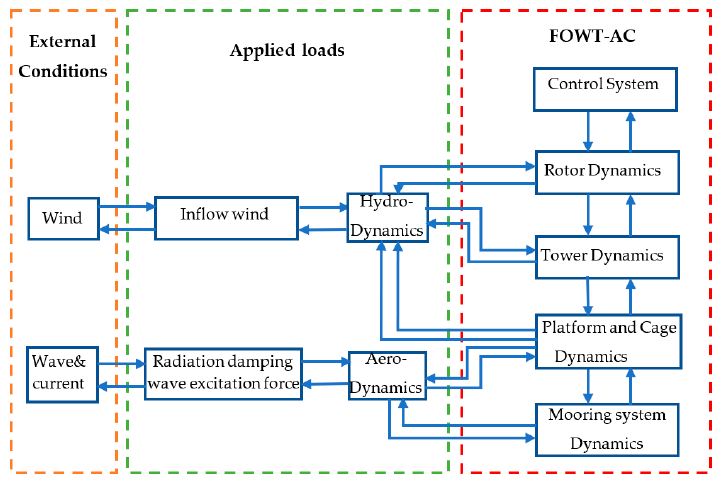
Figure 8. Flow chart of numerical model.